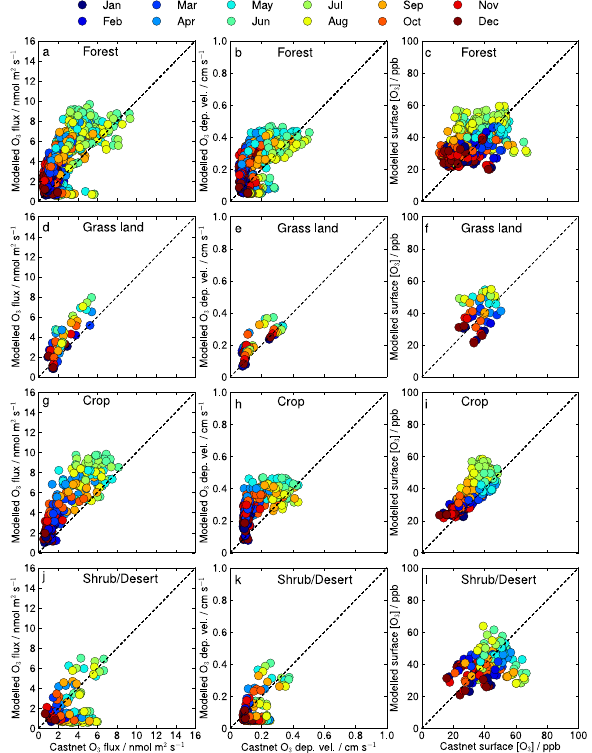
Figure 10. Comparison of CASTNET and modelled monthly aver- age O 3 dry deposition fluxes, O 3 dry deposition velocities and sur- face O 3 at CASTNET measurement sites. The CASTNET sites are grouped by land cover class which are shown by row for forest sites (a – c) , grassland sites (d – f) , crop sites (g – i) and shrub/desert sites (j – l) . CASTNET and modelled fluxes at each site are compared in the left hand column, deposition velocities are shown in the middle column, and surface O 3 is compared in the right hand